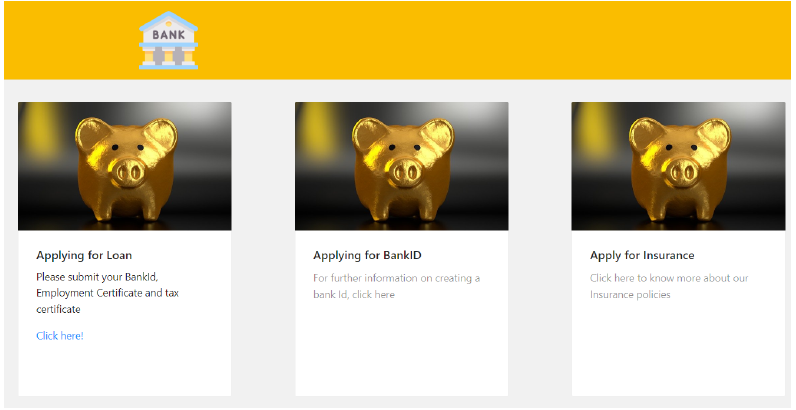
Figure 7. Bank’s web page with different features.